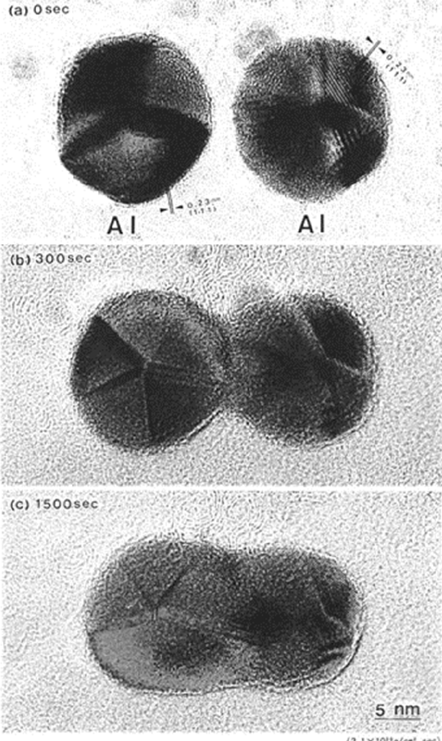
Figure 6. Al nanodecahedra ( a ) bonded by electron irradiation with an intensity of 2.1 × 10 20 e/cm 2 s after 300 s ( b ) and coalesced after 1500 s ( c ). The (111) planes in two Al nanodecahedra were aligned parallel by rotation and exhibited a Σ 3 coincidence site lattice (CSL) boundary around the neck at 300 s [5,7].